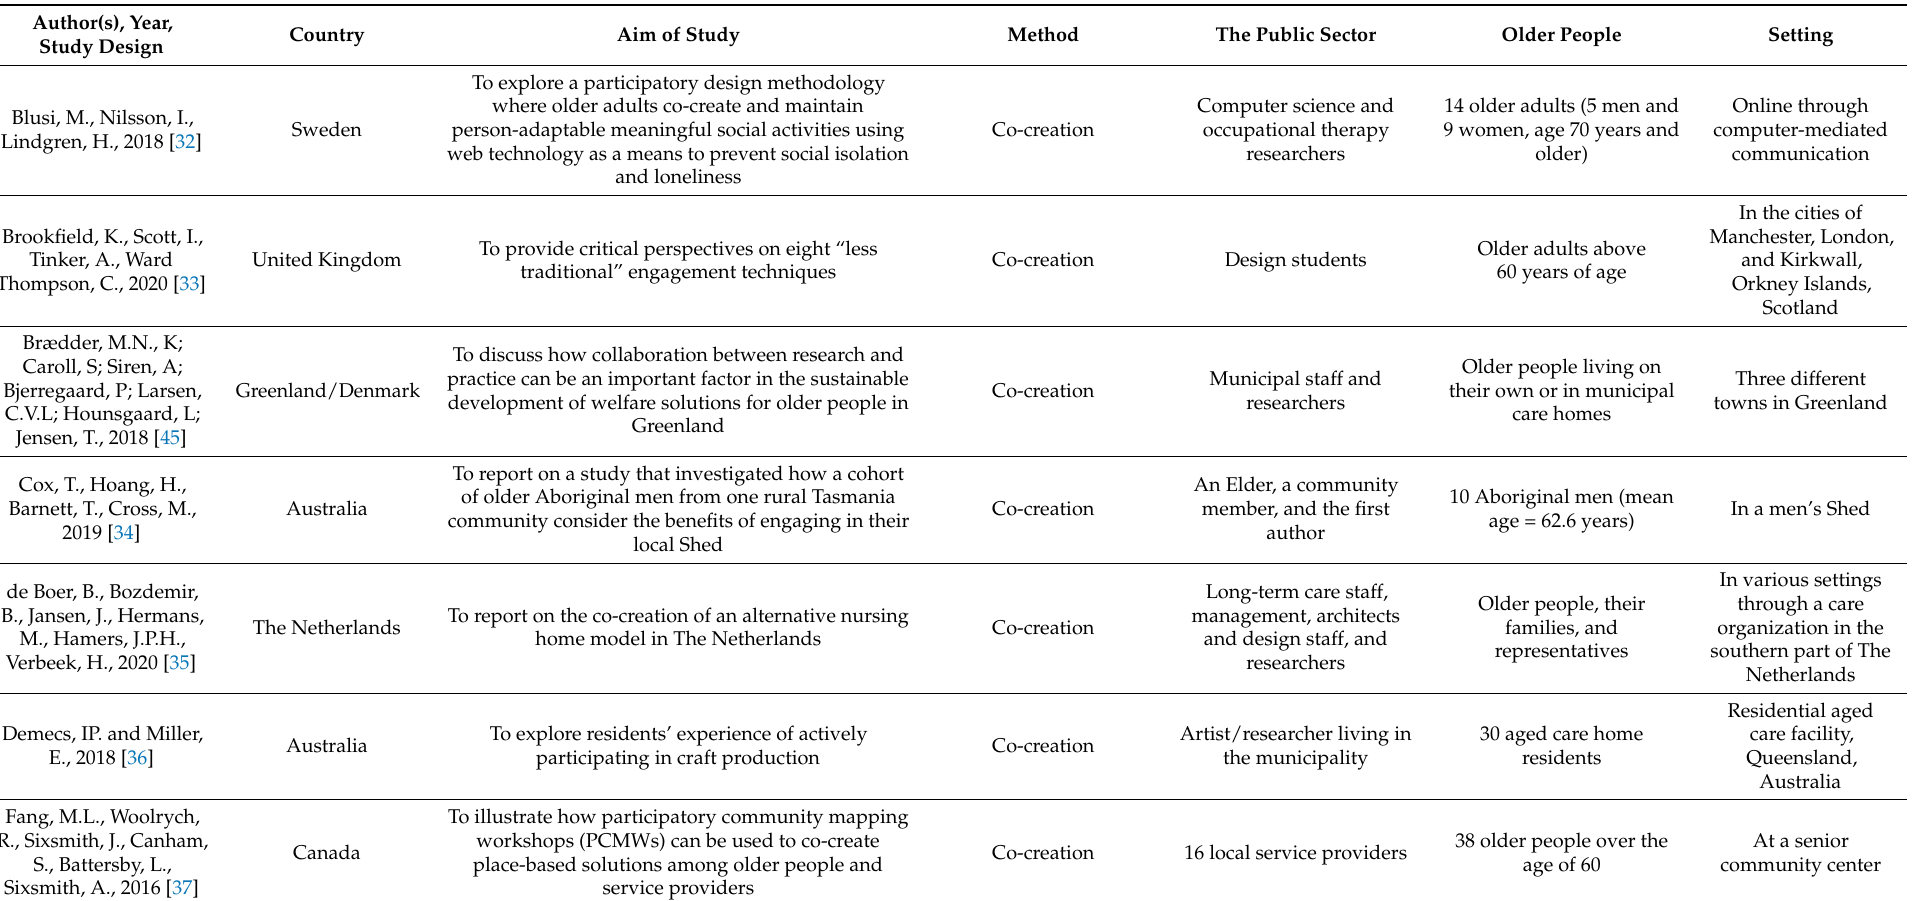
Table A1. Study characteristics of included